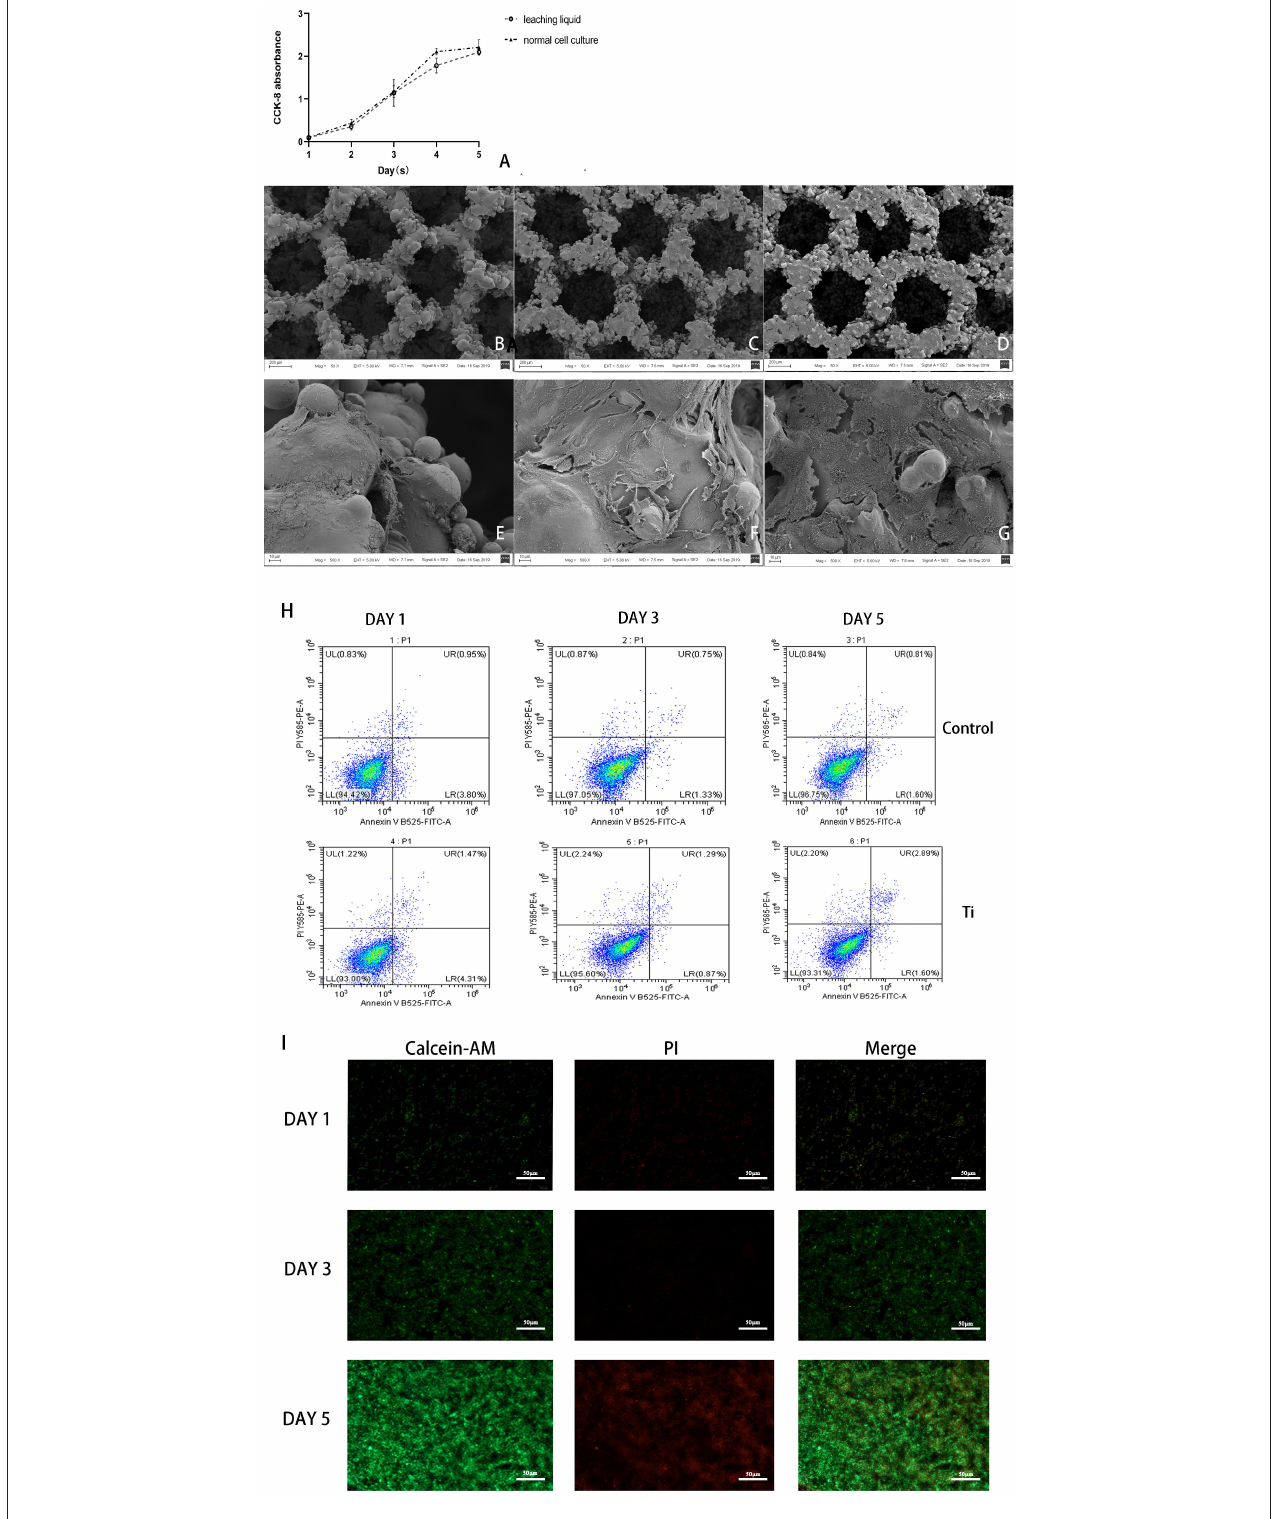
FIGURE 3 | The biosafety of the scaffold were verified after co-cultivation with the scaffold. (A) CCK-8 test of cell proliferation in leaching liquid and ordinary culture medium, and in both situations, cells proliferate actively with no statistical difference ( p > 0.05). (B–G) SEM scanning of L6 myoblast cultivated on the